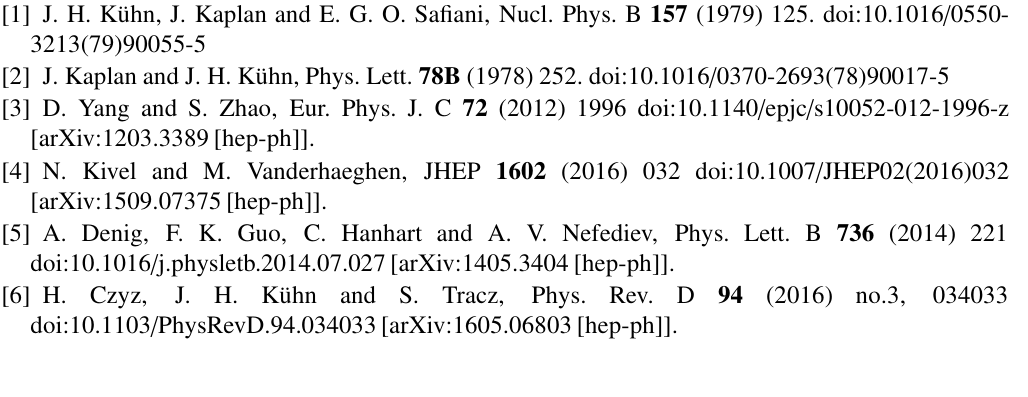
µ + µ − γ in the χ 2 - →